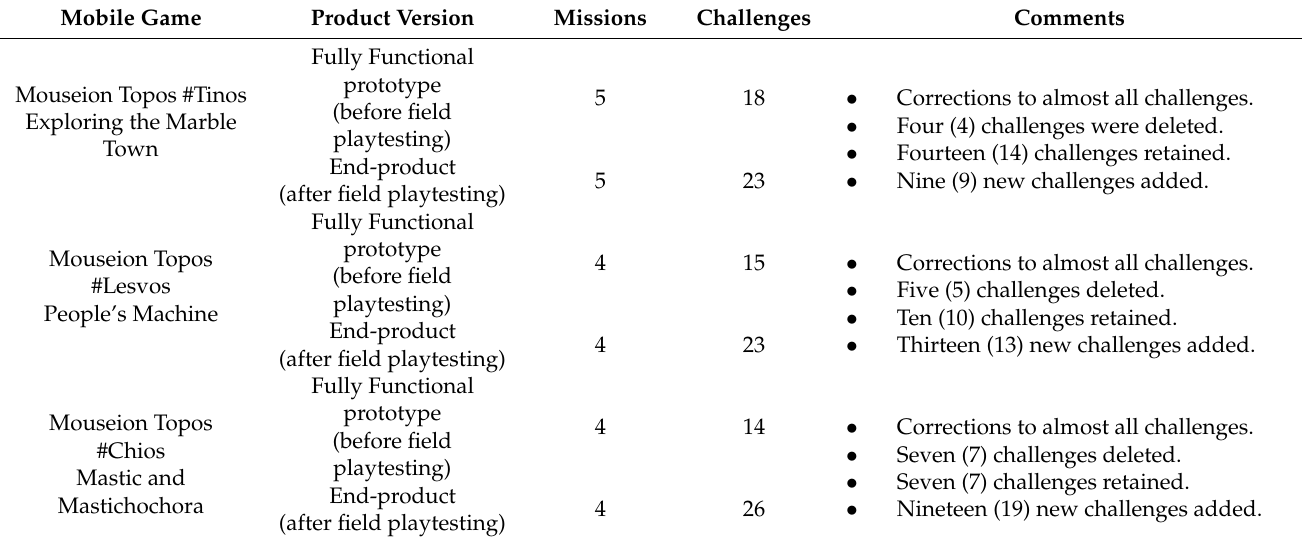
Table 5. Summary of cultural content in product versions of the mobile games (before and after field